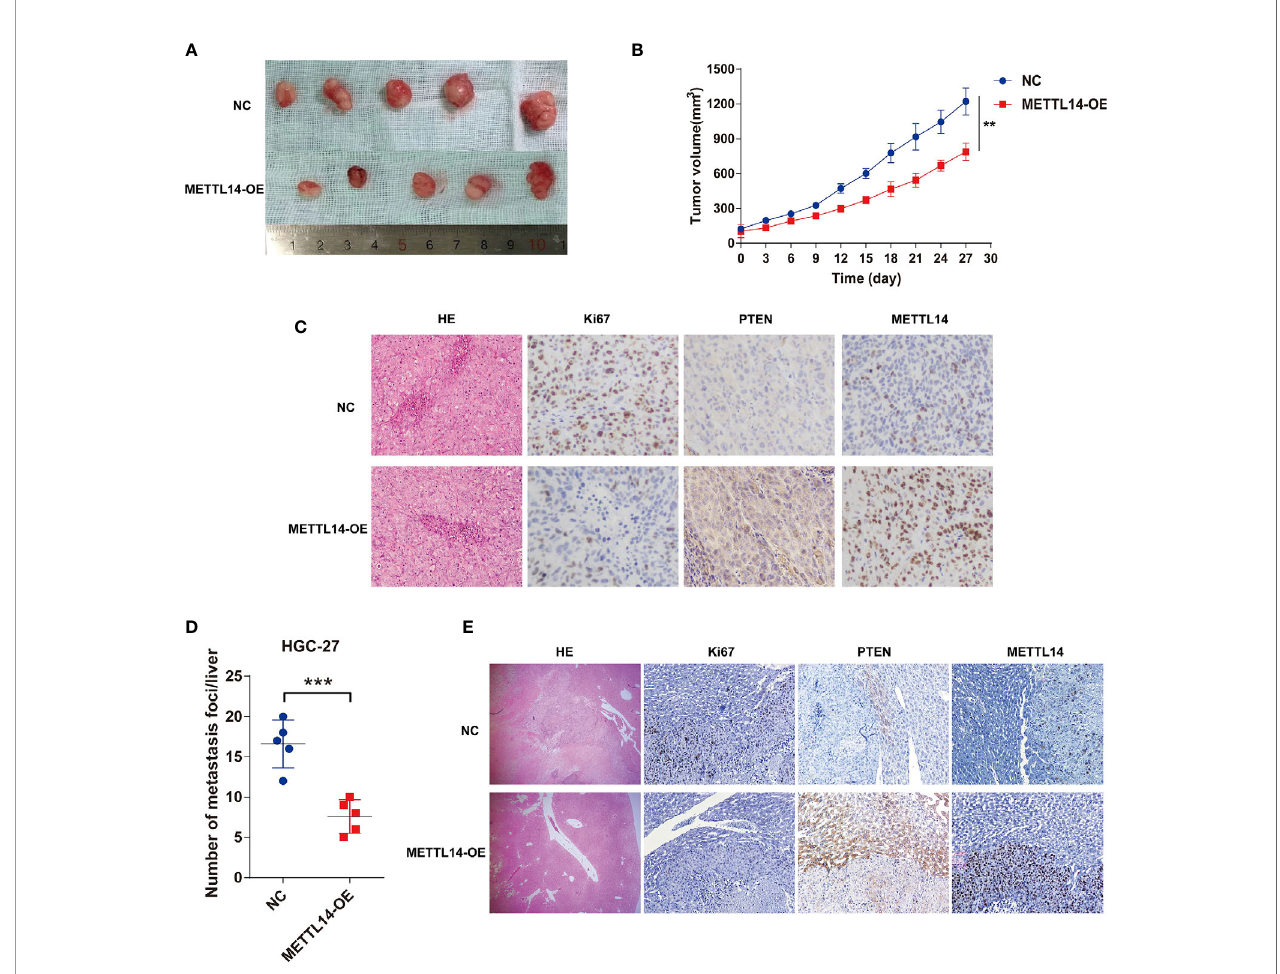
FIGURE 6 | METTL14 inhibits STAD growth and metastasis in vivo . (A) The representative tumors of METTL14 overexpression or negative control HGC-27 cell after transplanting in nude mice. (B) Comparison of tumor volumes of transplanted tumor nude mice between METTL14 overexpression or negative HGC-27 cells. (C) Comparison of metastasis foci in liver of STAD liver metastasis orthotopic tumor models between METTL14 overexpression or negative HGC-27 cells. (D) The representative pictures of HE-stained, Ki67, PTEN and METTL14 expression in STAD subcutaneous xeno transplantation model. (E) The representative pictures of HE-stained, Ki67, PTEN and METTL14 expression in liver metastasis sites of STAD tumor in orthotopic tumor models. (**P < 0.01; ***P <